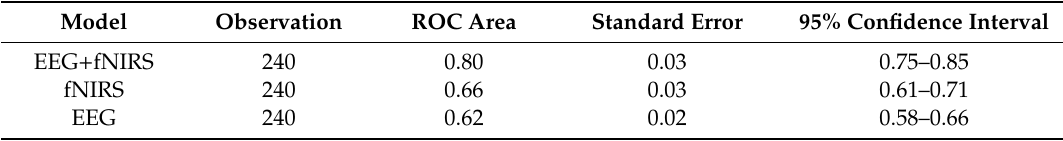
Figure 14. ROC curve comparison of the proposed method (EEG + fNIRS) and the ones where only EEG or fNIRS employed for all image-content trials